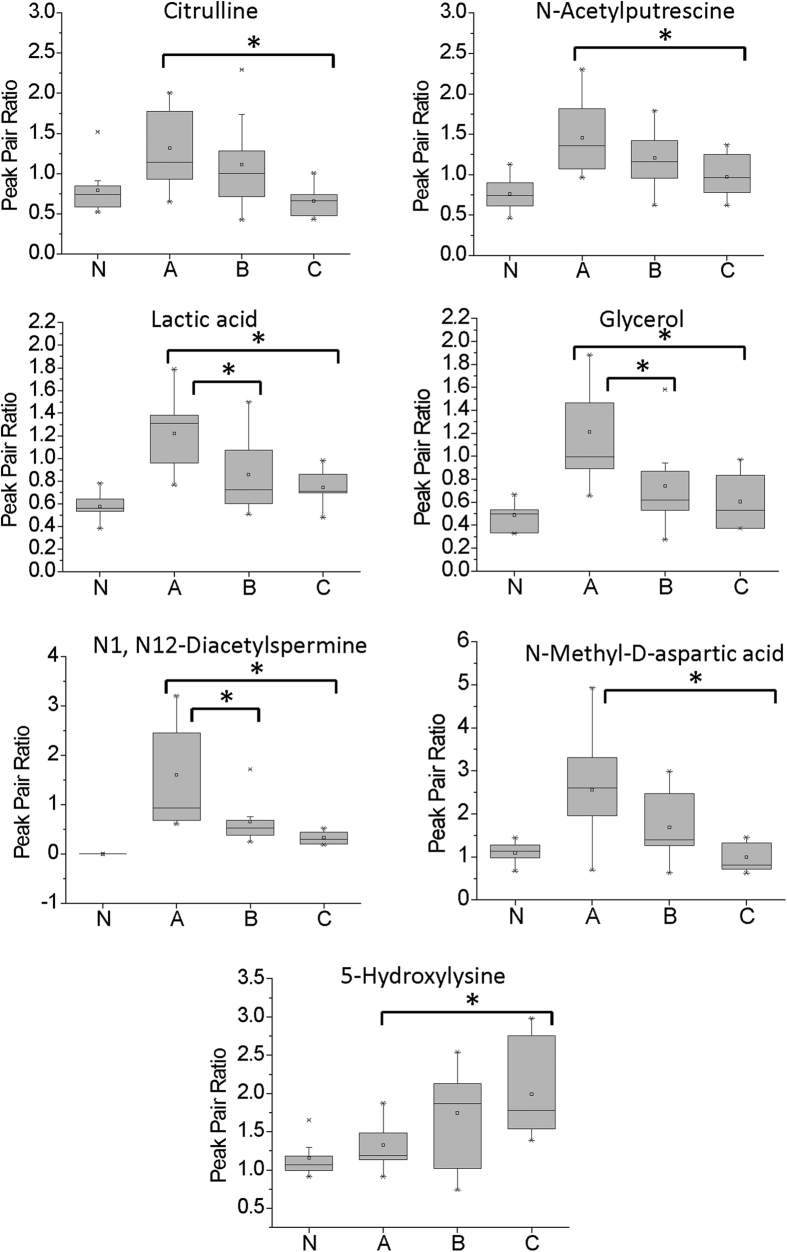
Box-and-whisker plot showing the relative abundance (expressed as peak pair ratios) of selected metabolites in different injury groups (A, B and C) and non-injured controls (N). The asterisk indicates a significant difference among AIS A, B and C (p < 0.05).